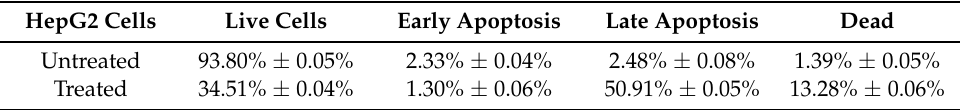
Table 1. Apoptosis studies. The percentages of live, total apoptotic, and dead cells are reported for HepG2 cells before and after treatment with 137 µ g/mL of PECS at 48 h.